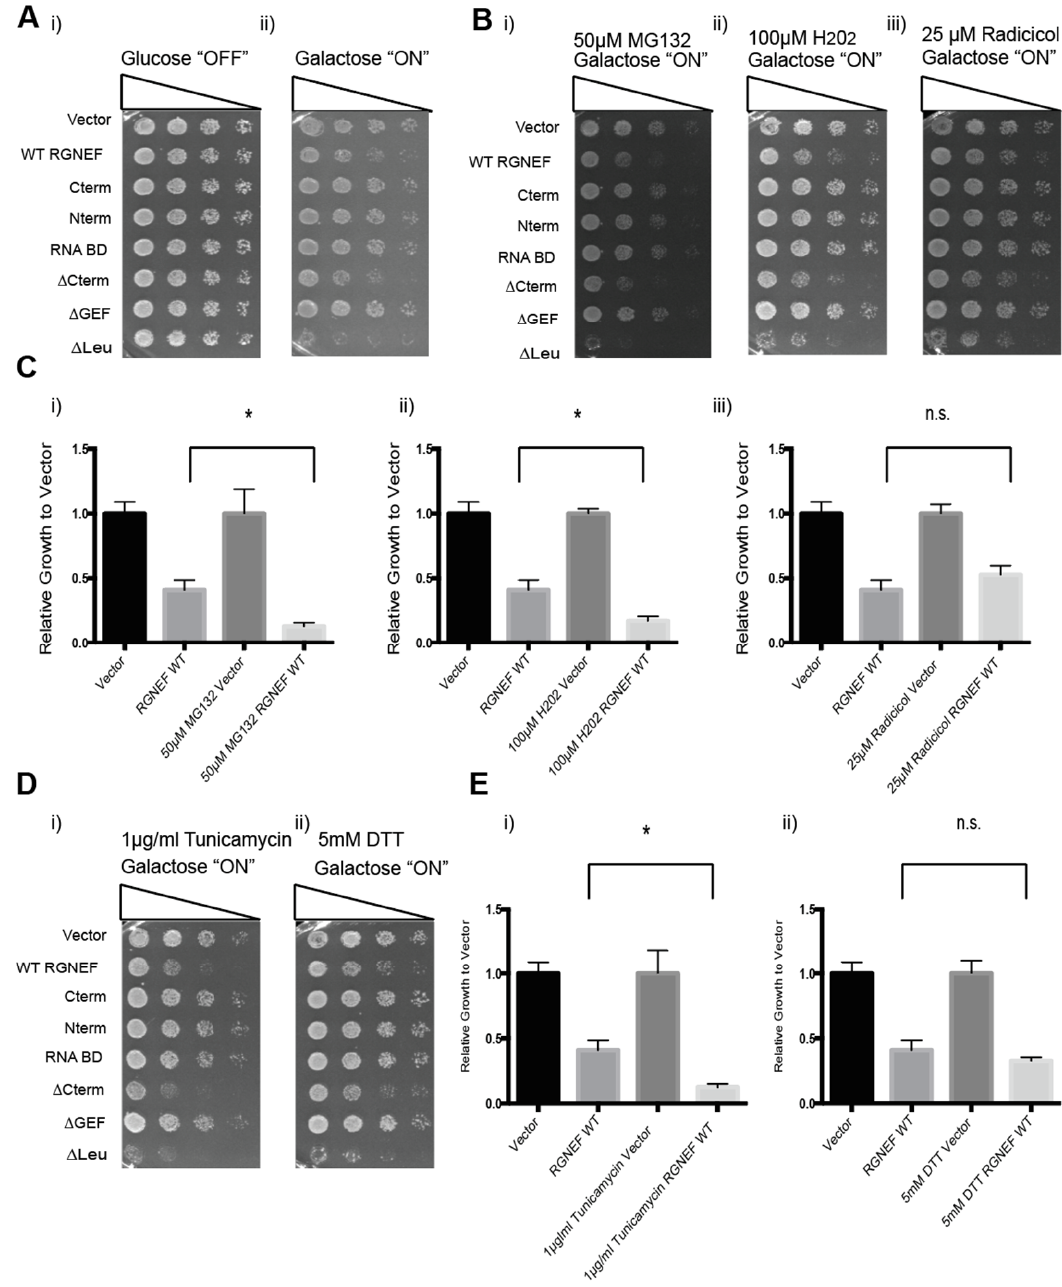
Figure 5. RGNEF toxicity under cellular stress. ( A ) Yeast growth assay of yeast cells under non-inducing (i) and inducing conditions (ii) for the expression of full length wild type and truncated RGNEF variants. ( B ) Yeast growth assay of cells expressing full length wild type and truncated RGNEF